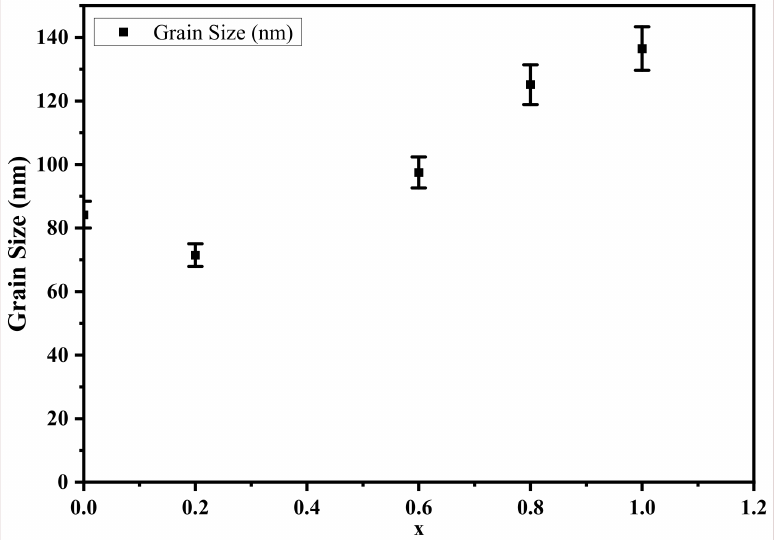
Mg + 2 Fe + 3 O 4 (x = 0, 0.2, 0.6, 0.8, and x 2 1 − x